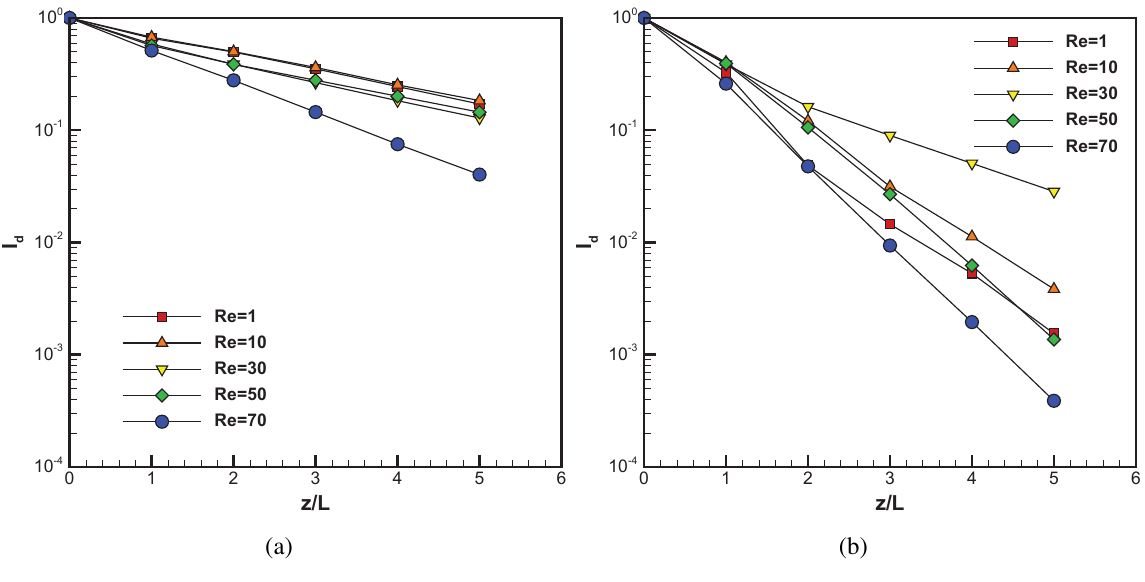
Figure 9. Effect of the Reynolds number on the evolution of the intensity of segregation I in two mixers with ( a ) α = 0 . 25 and ( b ) α = 1 . Here, the abscissa is the normalized d down-channel position, defined by z/L , where L is the length of one period.